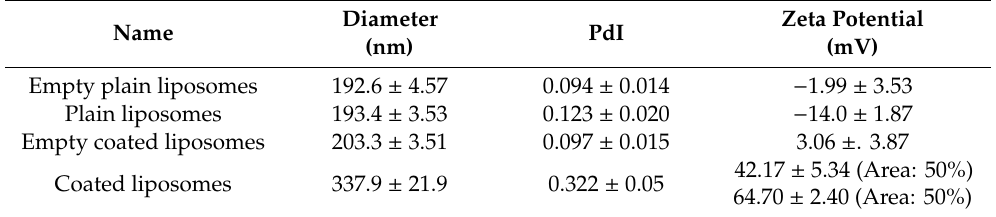
Table 3. Liposome characteristics: diameter, polydispersity index (PdI), and zeta potential (mean ± SD, n =